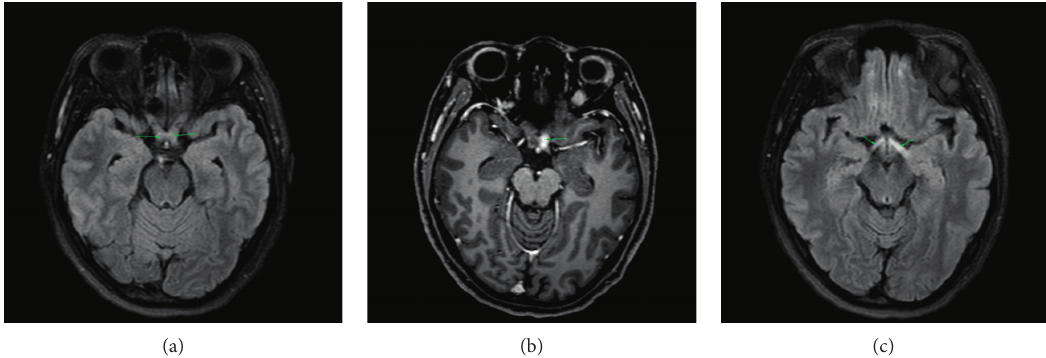
Figure 1: (a): FLAIR Axial image showing thickening and increased signal intensity in the optic chiasm. (b): T-1 weighted post Gadolinium contrast Axial image showing enhancement in the left side of the optic chiasm. (c): FLAIR Axial image showing increased signal intensity in the bilateral optic tracts. (Left >